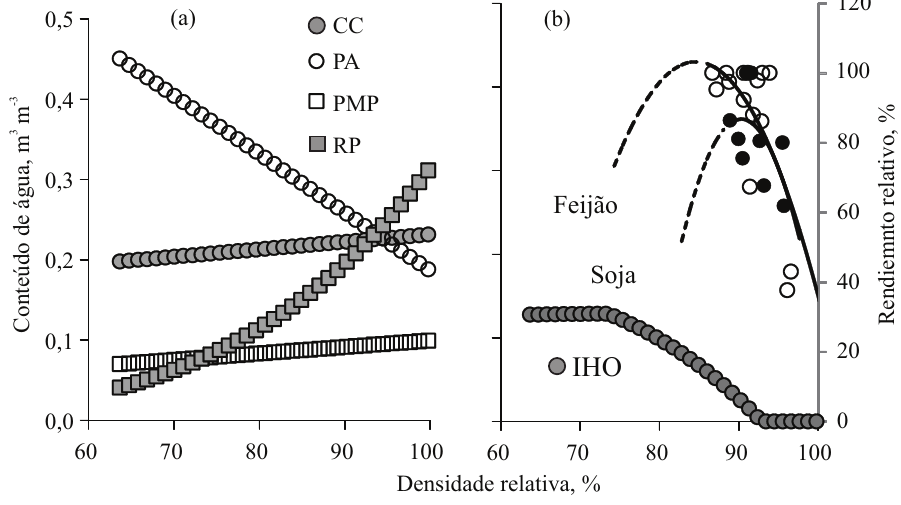
Figura 1. (a) Diagrama do intervalo hídrico ótimo de um Argissolo Vermelho Distrófico (adaptado de Collares et al., 2006, substituindo-se a densidade do solo pela densidade relativa descrita em Reichert et al., 2009). Os símbolos da legenda representam o conteúdo de água para uma porosidade de aeração de 10 % (PA), a resistência do solo à penetração de 2 MPa (RP), a capacidade de campo a 0,01 MPa (CC) e o ponto de murcha permanente a 1,5 MPa (PMP). (b) Conteúdo de água do intervalo hídrico ótimo (IHO) e rendimento relativo da soja (Streck, 2003; Collares et al., 2006) e feijão (Streck, 2003; Collares et al., 2006; Gubiani, 2008) no mesmo Argissolo. O valor máximo das equações polinomiais quadráticas não coincide com rendimento relativo 100 % por questões de ajuste aos dados experimentais (r²=0,65 e p<0,05 para feijão - círculos sem preenchimento - e r²=0,32 e p<0,05 para soja - círculos preenchidos). Os trechos pontilhados representam o prolongamento das equações para valores de densidades menores que os valores verificados nos experimentos de